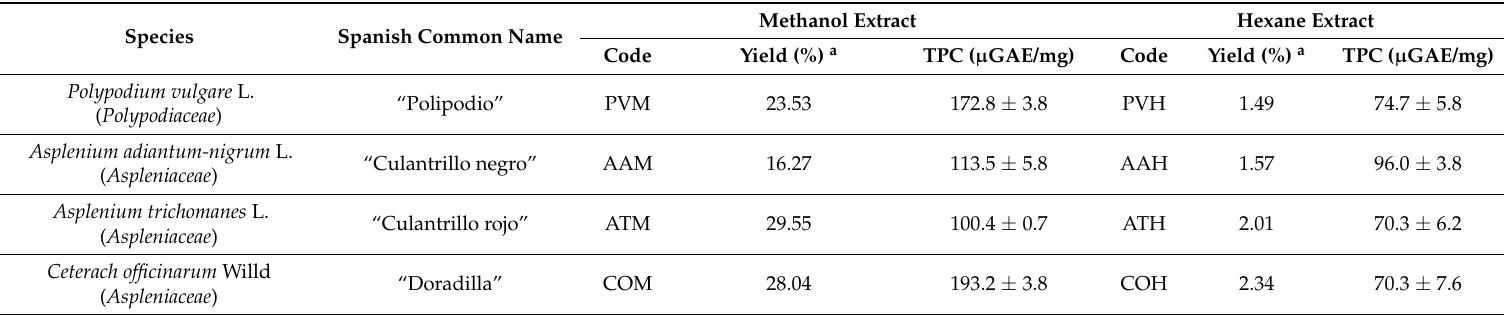
Table 1. Fern samples, botanical names, yields of extraction, and total polyphenol content